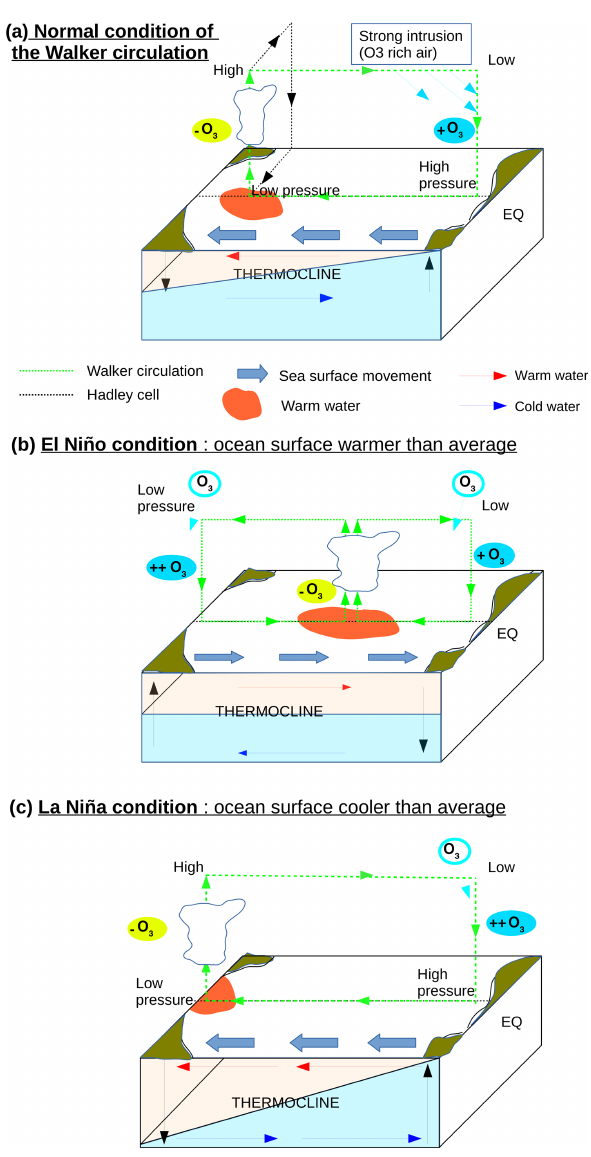
Figure 1. Schematic of the Walker circulation over the Pacific ocean. (a) During normal conditions: trade winds induce subsidence along South America with intrusion of O 3 -rich air. The TCO is el- evated. In addition, along Indonesia, warmer waters generate con- vergence that results in low O 3 concentrations. The TCO is weak- ened (b) during El Niño events: easterly trade winds are weakened. Therefore, convergence areas are located near the coast of South America while subsidence zones are located in the Indonesia. Low TCO is located over the Pacific ocean while high TCO is located over Indonesia, and (c) during La Niña events: during exceptionally strong trade winds the convergence over the Indonesia is stronger. The TCO has the lowest value. Subsidence over South America brings air masses with high O 3 concentration, resulting in higher TCO than average